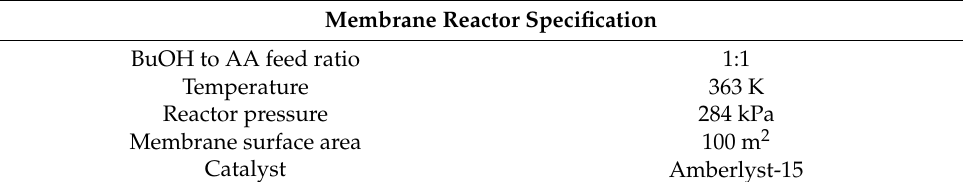
Figure 8. Process flow diagram (PFD) of butyl acetate production using a membrane reactor. Table 3. Reactor design specifications for the membrane reactor process.